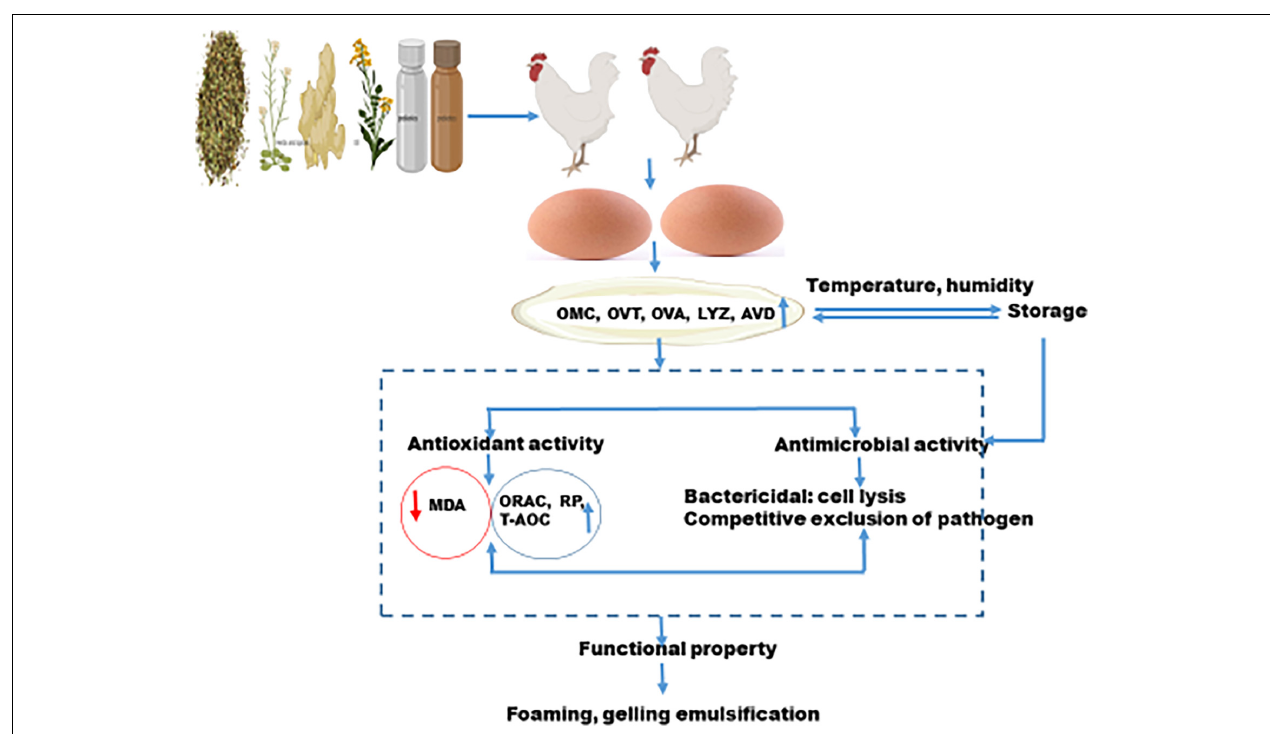
FIGURE 4 | Mechanism of action of diets on albumen